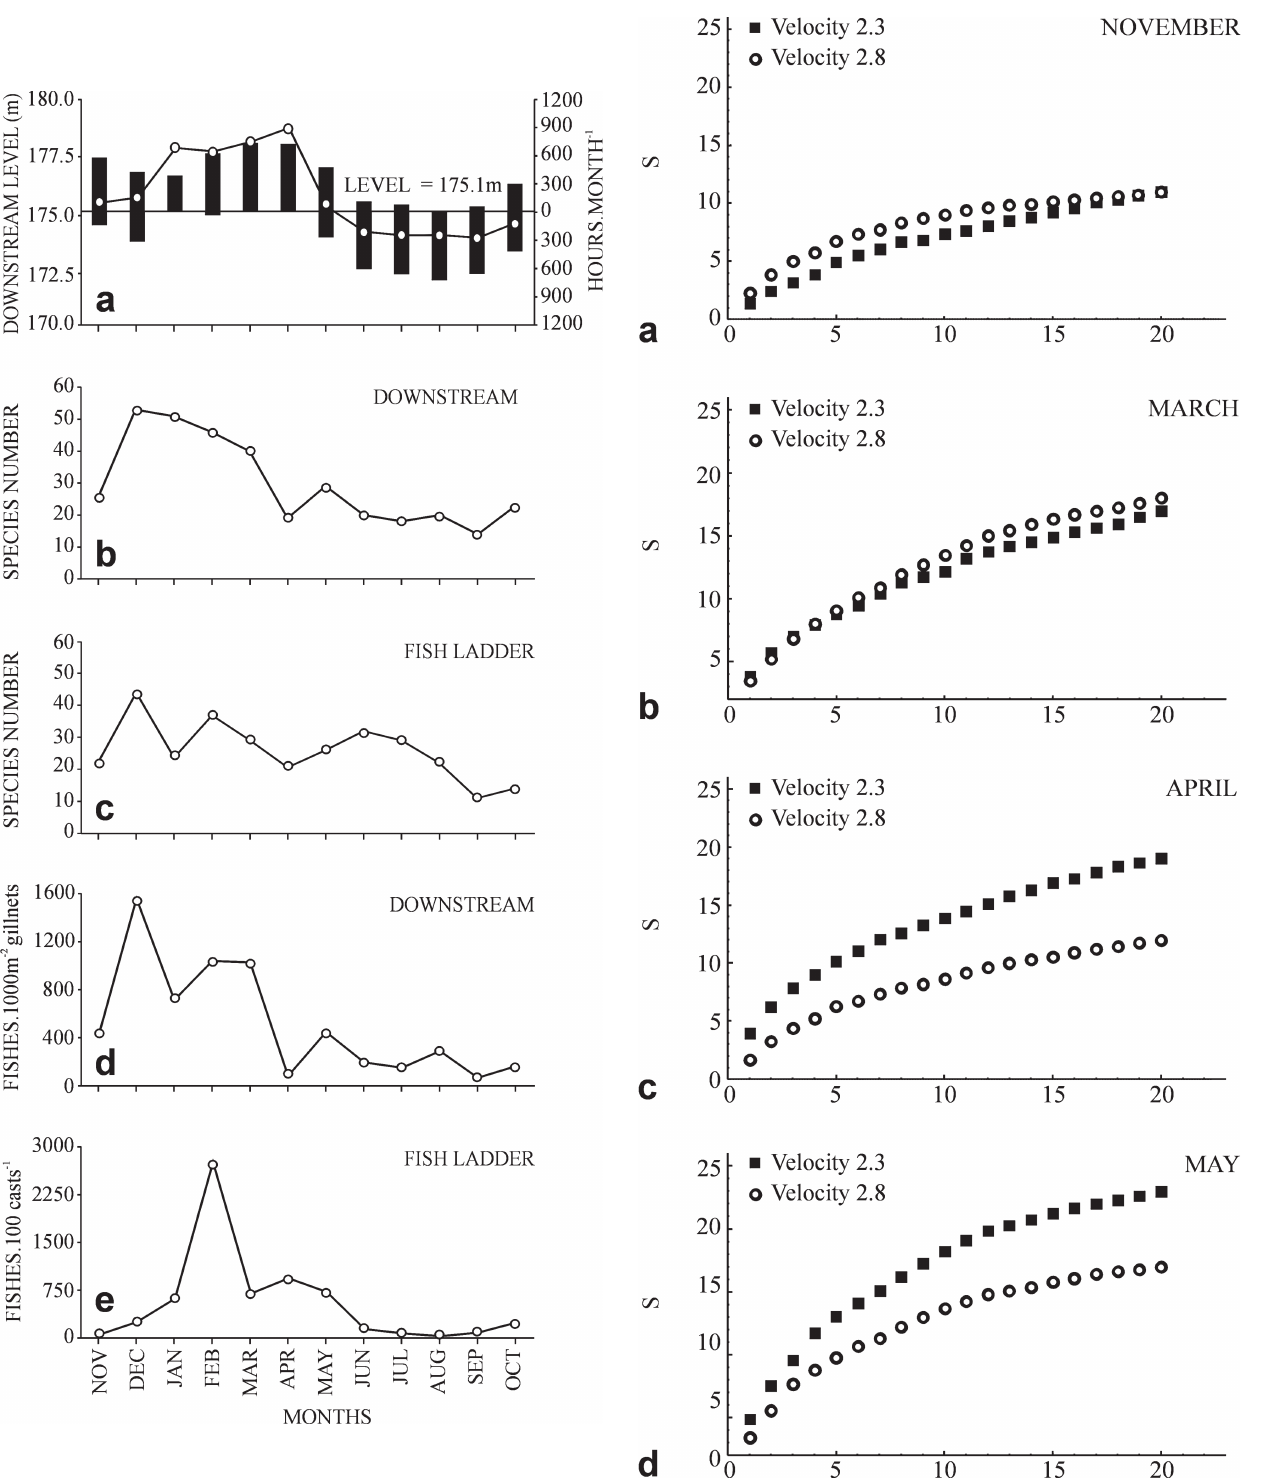
Fig. 4. Monthly mean water levels downriver (line) and the number of hours with elevations less than 175.1 m (columns) (a), the number and abundance of fish species in samples downstream from the dam (b and d) and from the fish ladder (c and e) of Lajeado Dam.